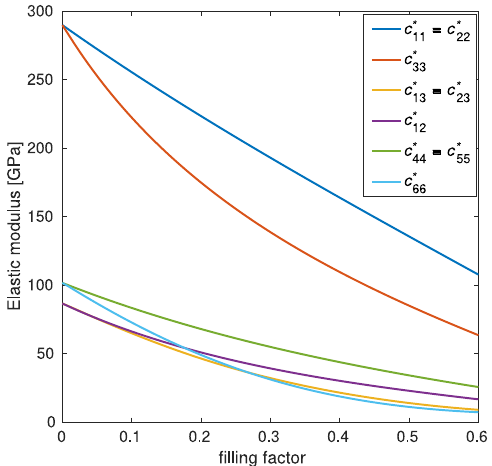
Fig. 2 Effective elastic stiffness tensor components of a SiN PnC metasolid as a function of the hole fi lling factor f . We have used the average eigenstrain approximation for a square lattice of in fi nitely long cylindrical holes aligned in the x 3